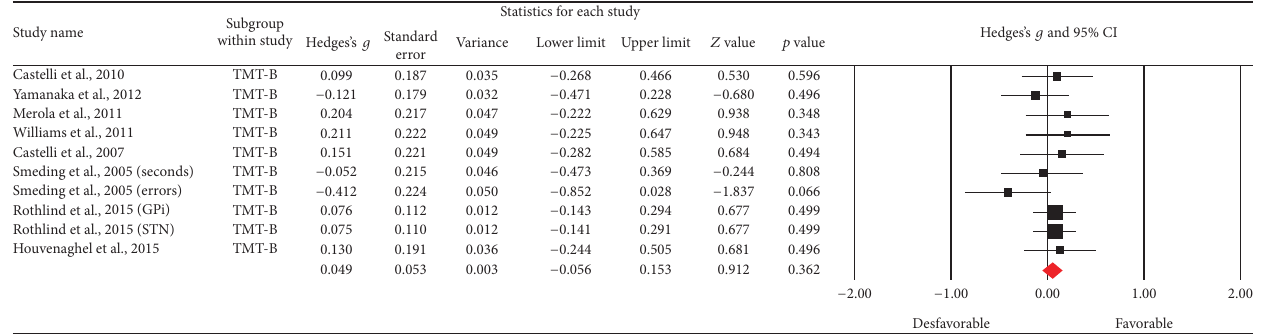
Figure 9: Meta-analysis of TMT-B comparing before and after DBS surgery.